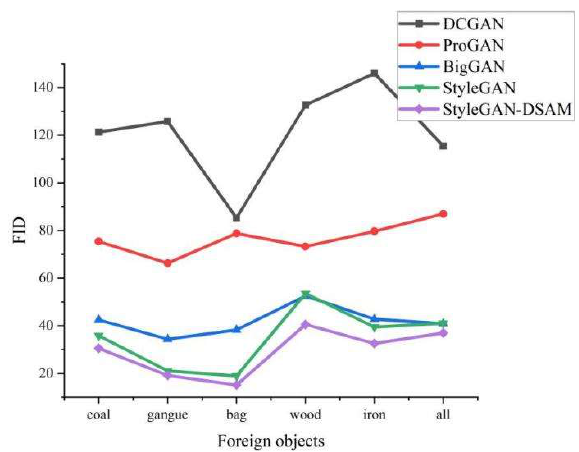
Figure 11. Comparison of FID.